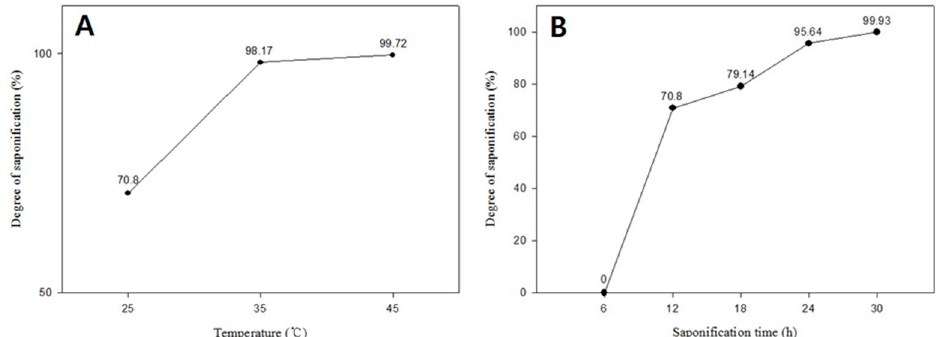
Figure 8. ( A ) The effect of saponification temperature on the degree of saponification (DS) (%) of PVA saponified for 12 h; ( B ) The effect of saponification time on the DS of PVA saponified at 25 °C. The concentration of the saponification solution (NaOH, Na 2 SO 4 , and MeOH at 10 g each per 100 g of H 2 O) was kept constant.